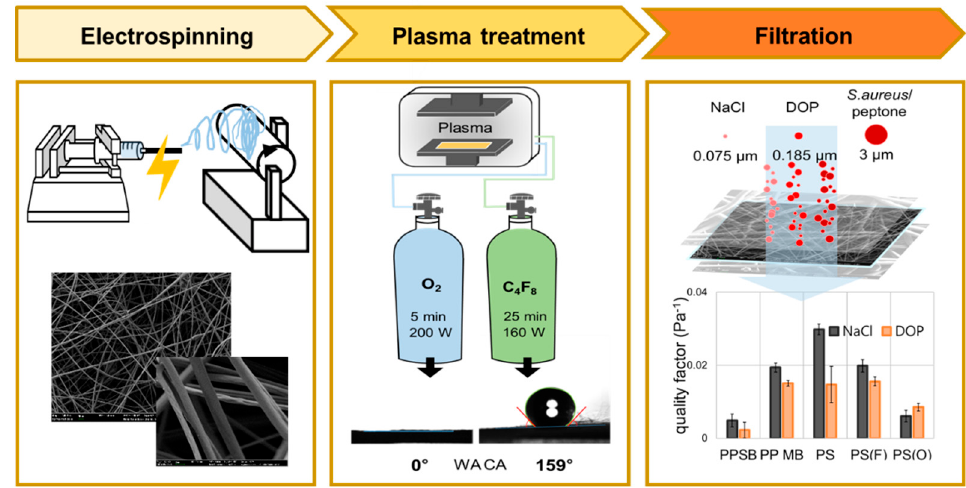
Figure 1. Schematic overview of study.